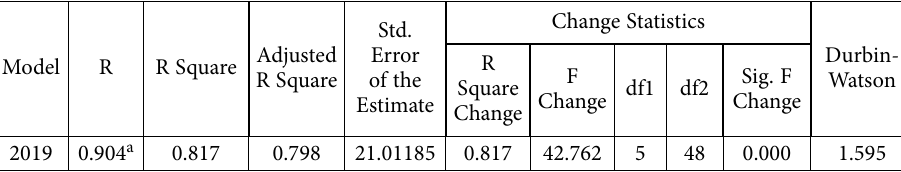
Table 11. Seasonal sustainability function for 2019 Model R R Square